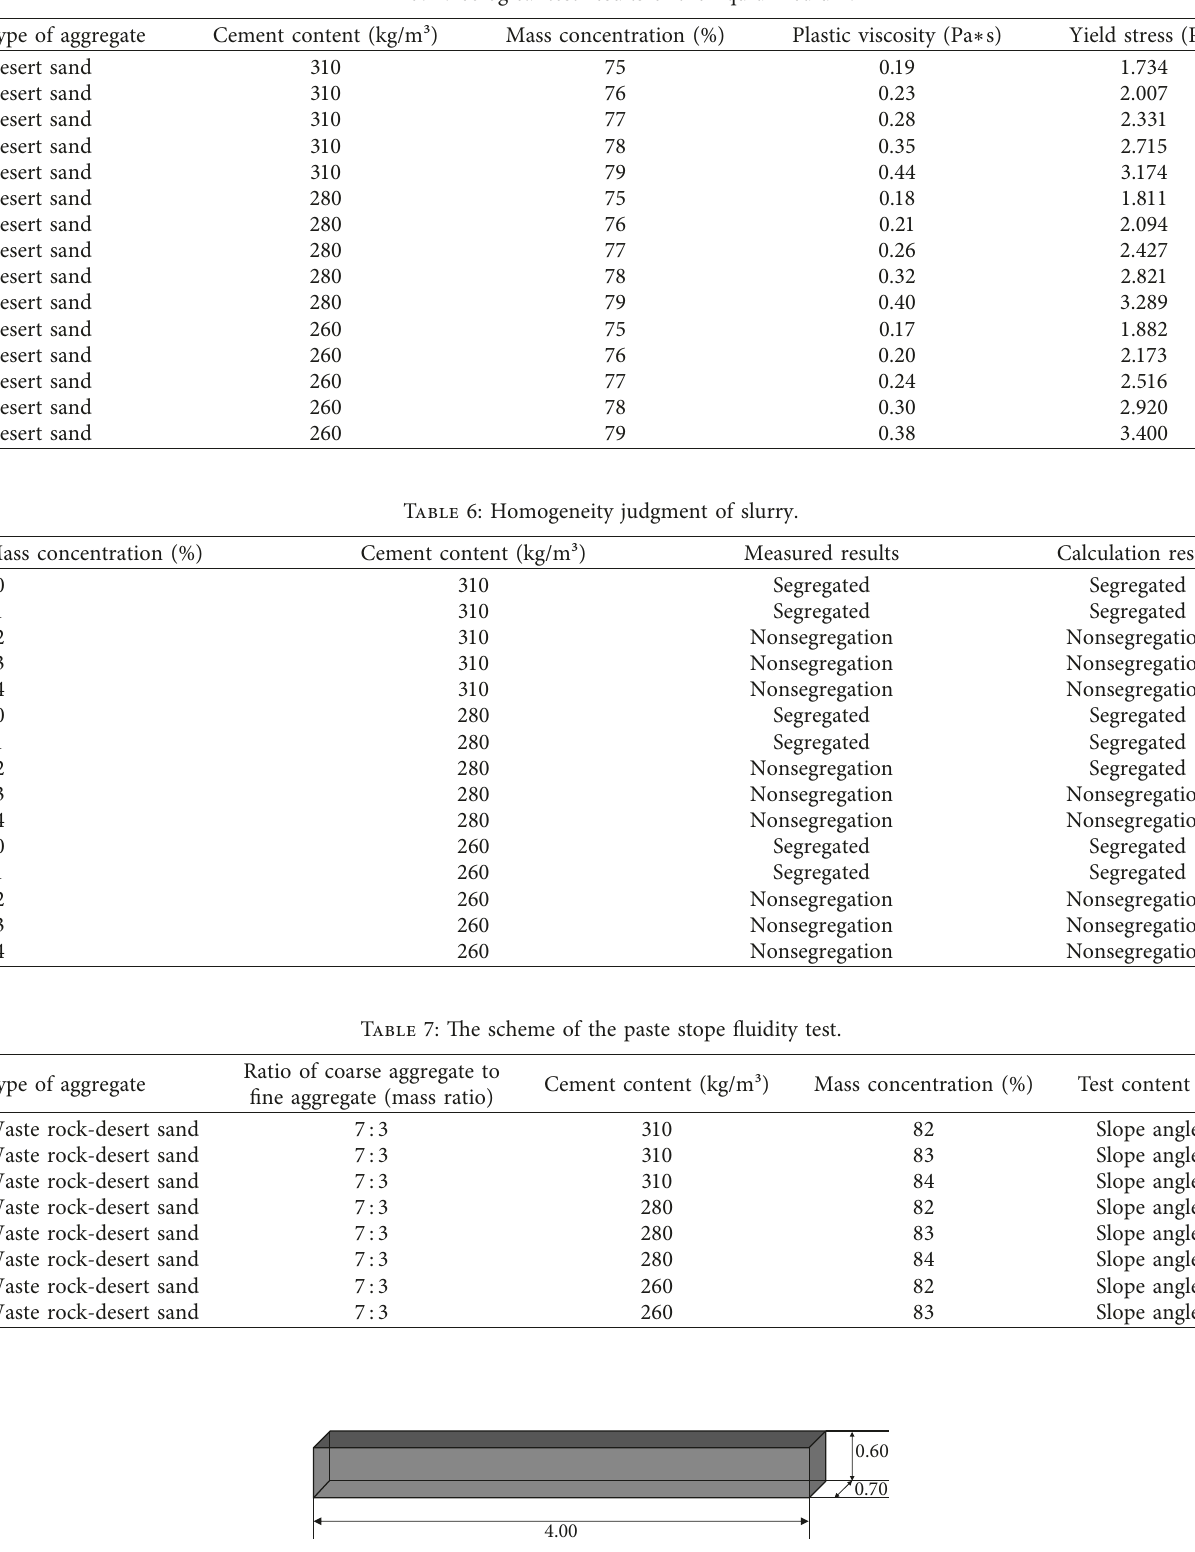
Table 5: Rheological test results of the liquid medium.